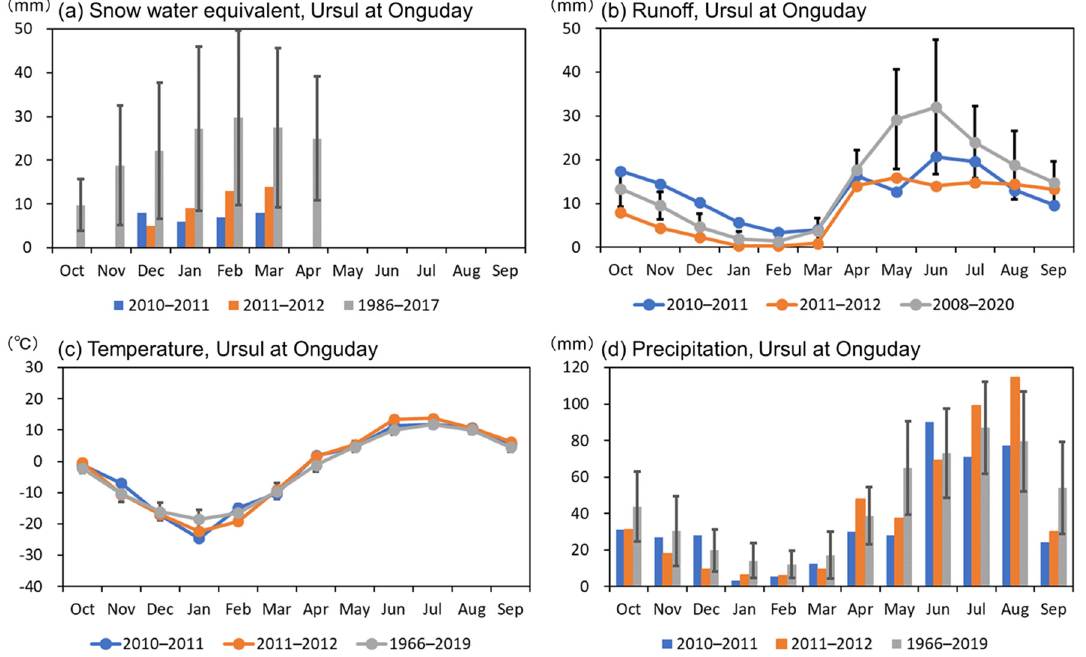
Figure 9. Same as Figure 7, but for Ursul at Onguday in South WS.